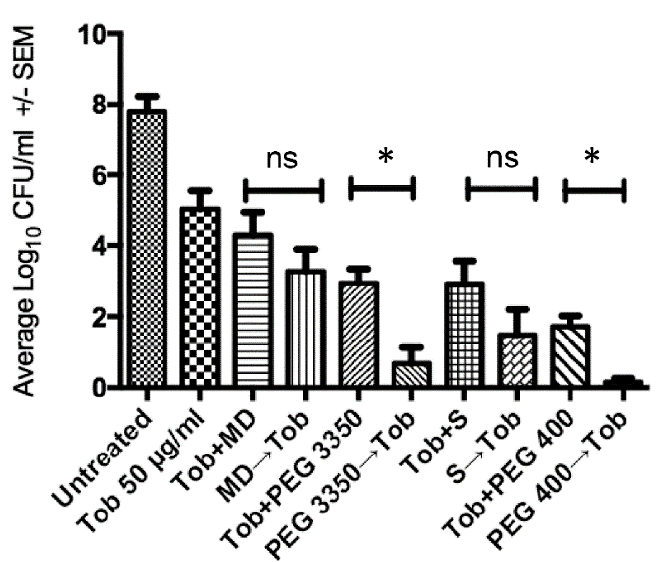
Figure 1. E ff ects of antibiotic alone, combined ( + ) or sequential ( → ) treatment with osmotic compounds maltodextrin (MD), sucrose (S), polyethylene glycol (PEG 3350 or PEG 400) and tobramycin (Tob, 50 µ g / mL) against Acinetobacter baumannii pre-formed biofilms. Error bars represent the standard error of the means calculated from three biological replicates. Statistical significance was calculated using one-way ANOVA with paired comparisons (Tukey’s test) for individual antibiotics with or without osmotic agent (* p < 0.05; ns = not